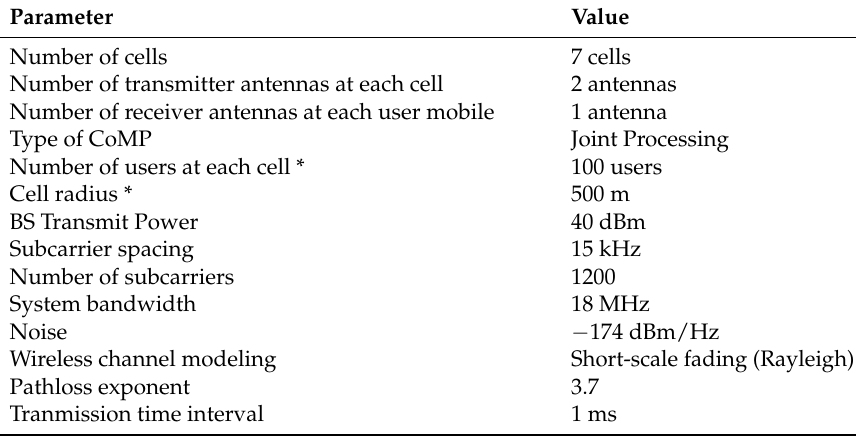
Table 1. Simulation